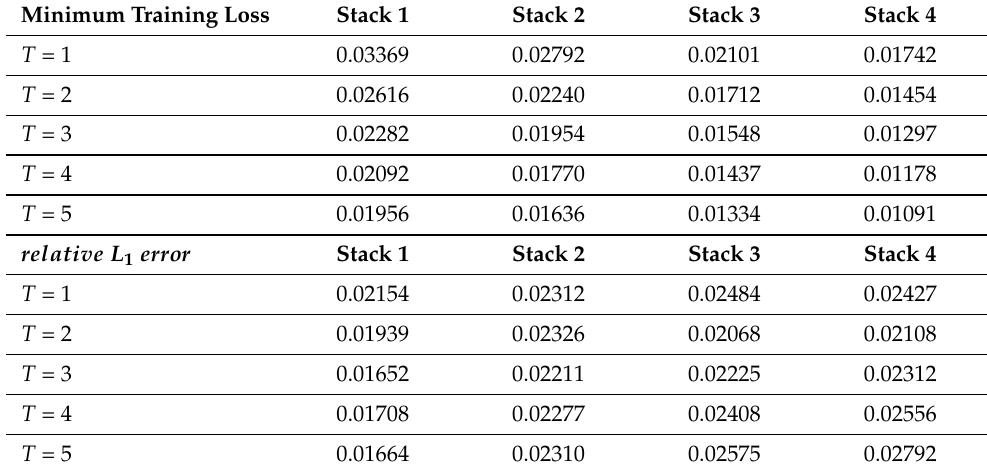
Table 5. The minimum training loss and average relative L 1 error at different stack numbers S.